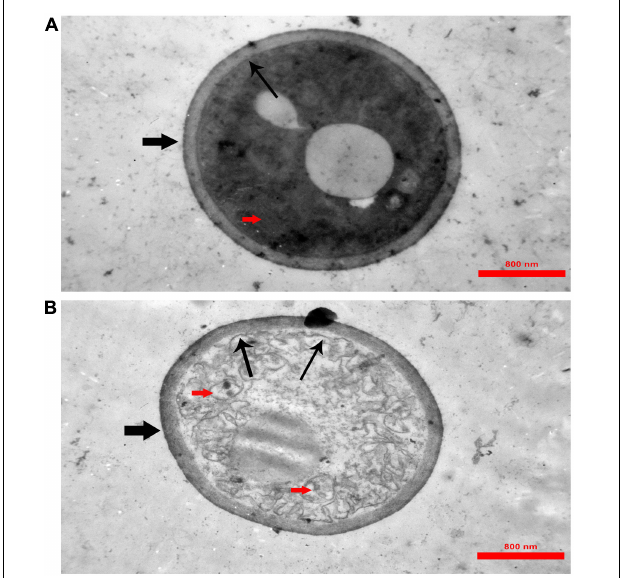
FIGURE 5 | Scanning electron microscopy of C. albicans cells treated with MCh-AMP1. Approximately 1 × 10 6 yeast cells were incubated without ( A , control) or with MCh-AMP1 (32 µ g/mL) (B) for 3 h. (A) SEM images of the untreated cells showed cells with normal shapes and smooth surfaces. (B) MCh-AMP1 treated cells showed a series of characteristic alterations, deep wrinkles and deformity (red arrows) along with oozing out of the intracellular content.